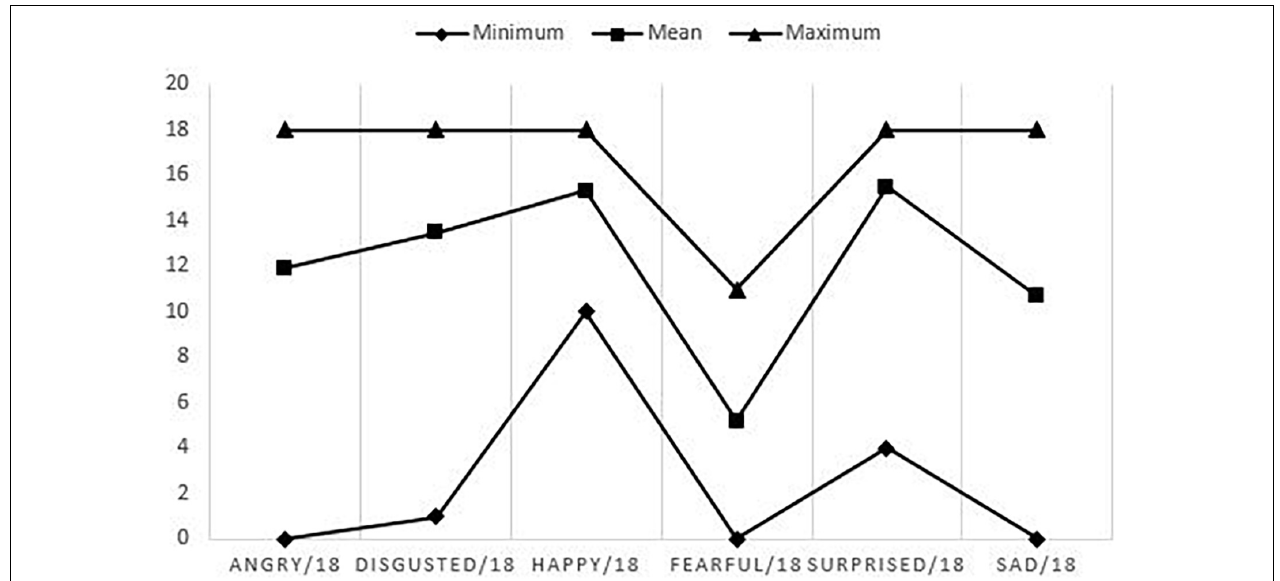
FIGURE 2 | Mean, minimum and maximum of scores according to each emotion on the static